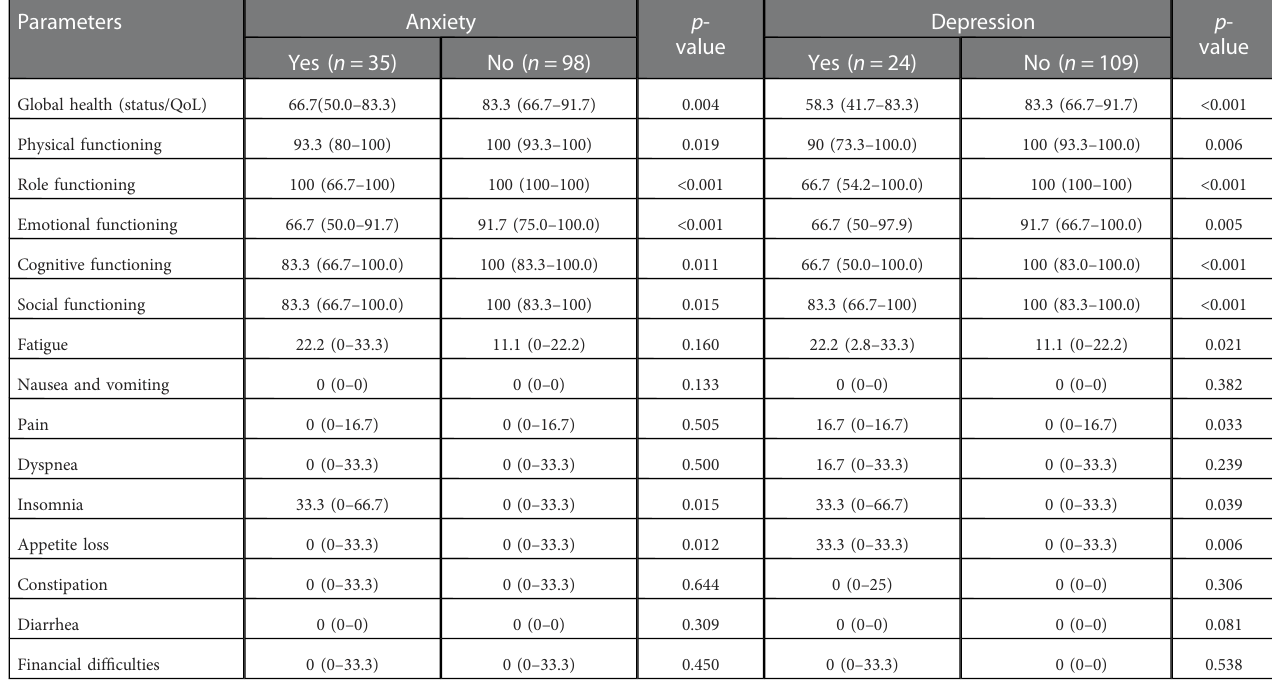
TABLE 5 Quality of life of the patients with pulmonary GGO before surgery.